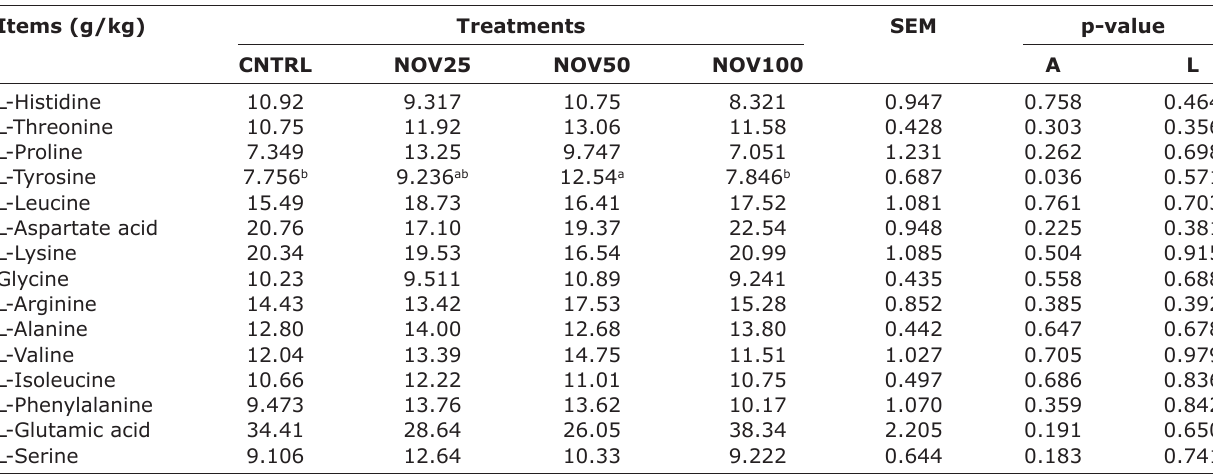
L-Isoleucine L-Glutamic